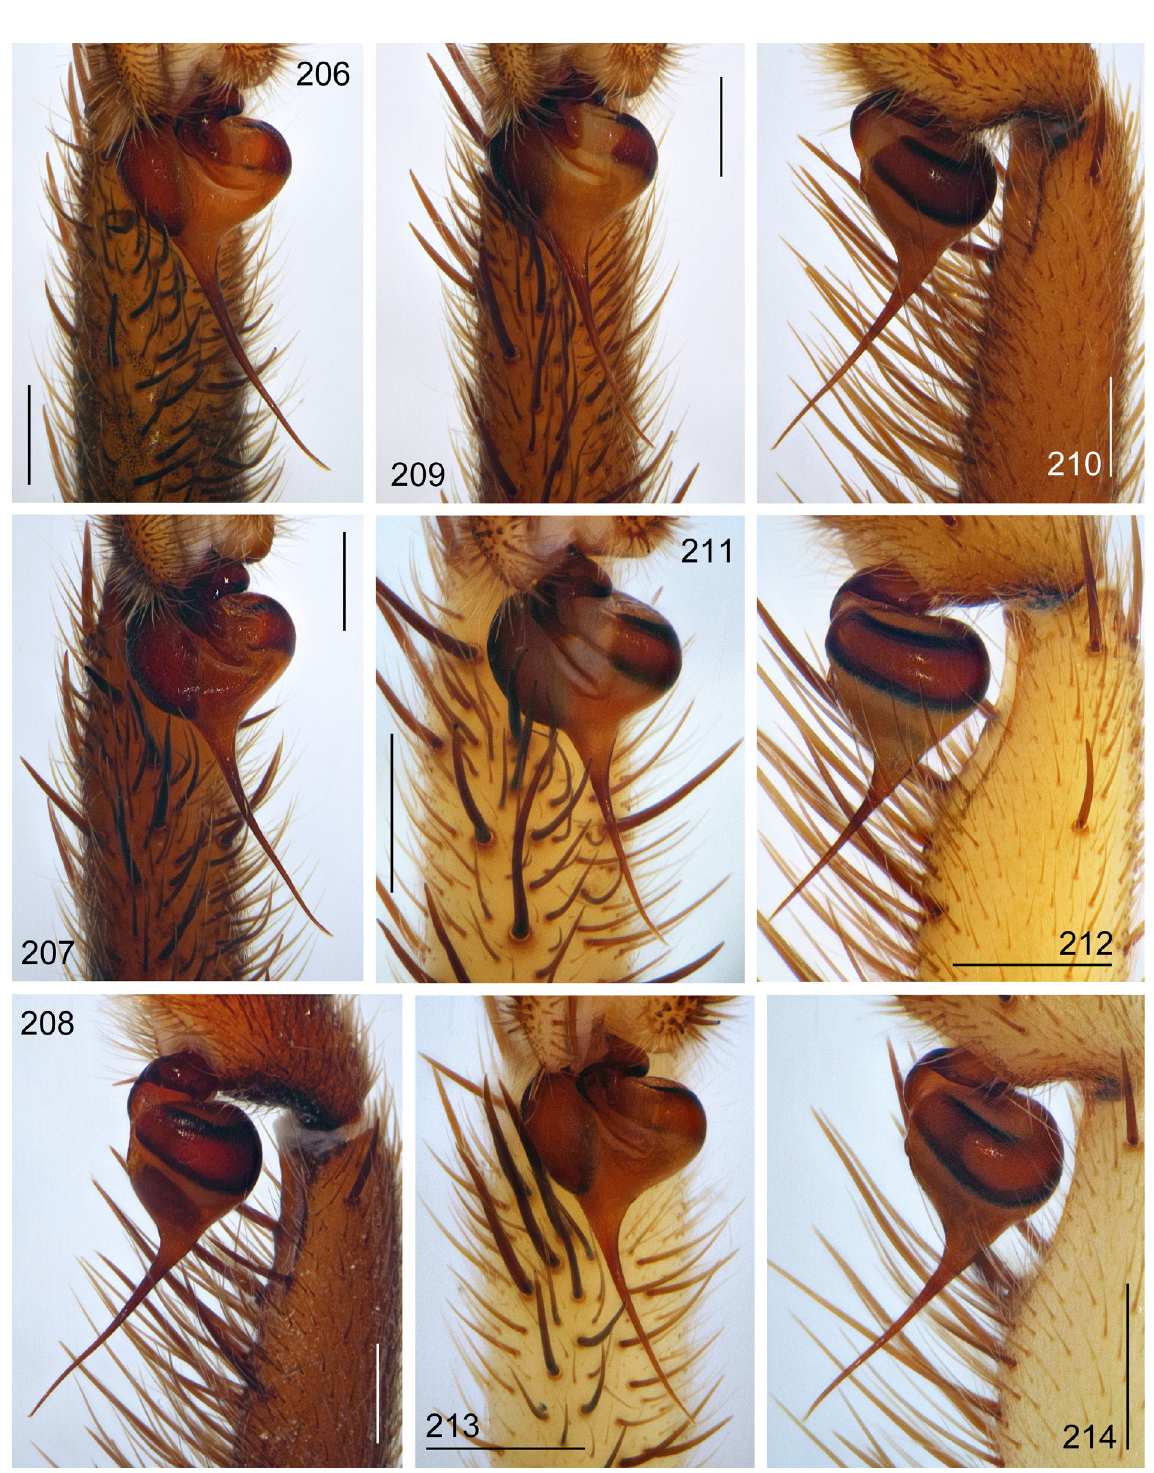
Figs 206–214. Anemesia spp., ♂♂, details of palpal organ; ventral (206–207, 209, 211, 213) and retrolateral (208, 210, 212, 214) views. 206–208 . A. castanea sp. nov. (paratype and holotype, respectively). 209–210 . A. karatauvi (Andreeva, 1968) (Hojamaston). 211–212 . A. pallida sp. nov. (holotype). 213–214 . A. parvula sp. nov. (holotype). Scale bars: